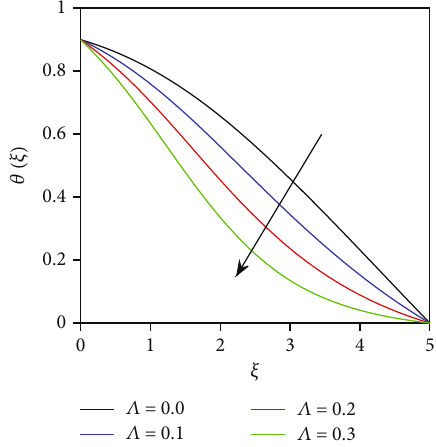
Figure 7: Temperature pro fi les for scaled stretching parameter Λ .